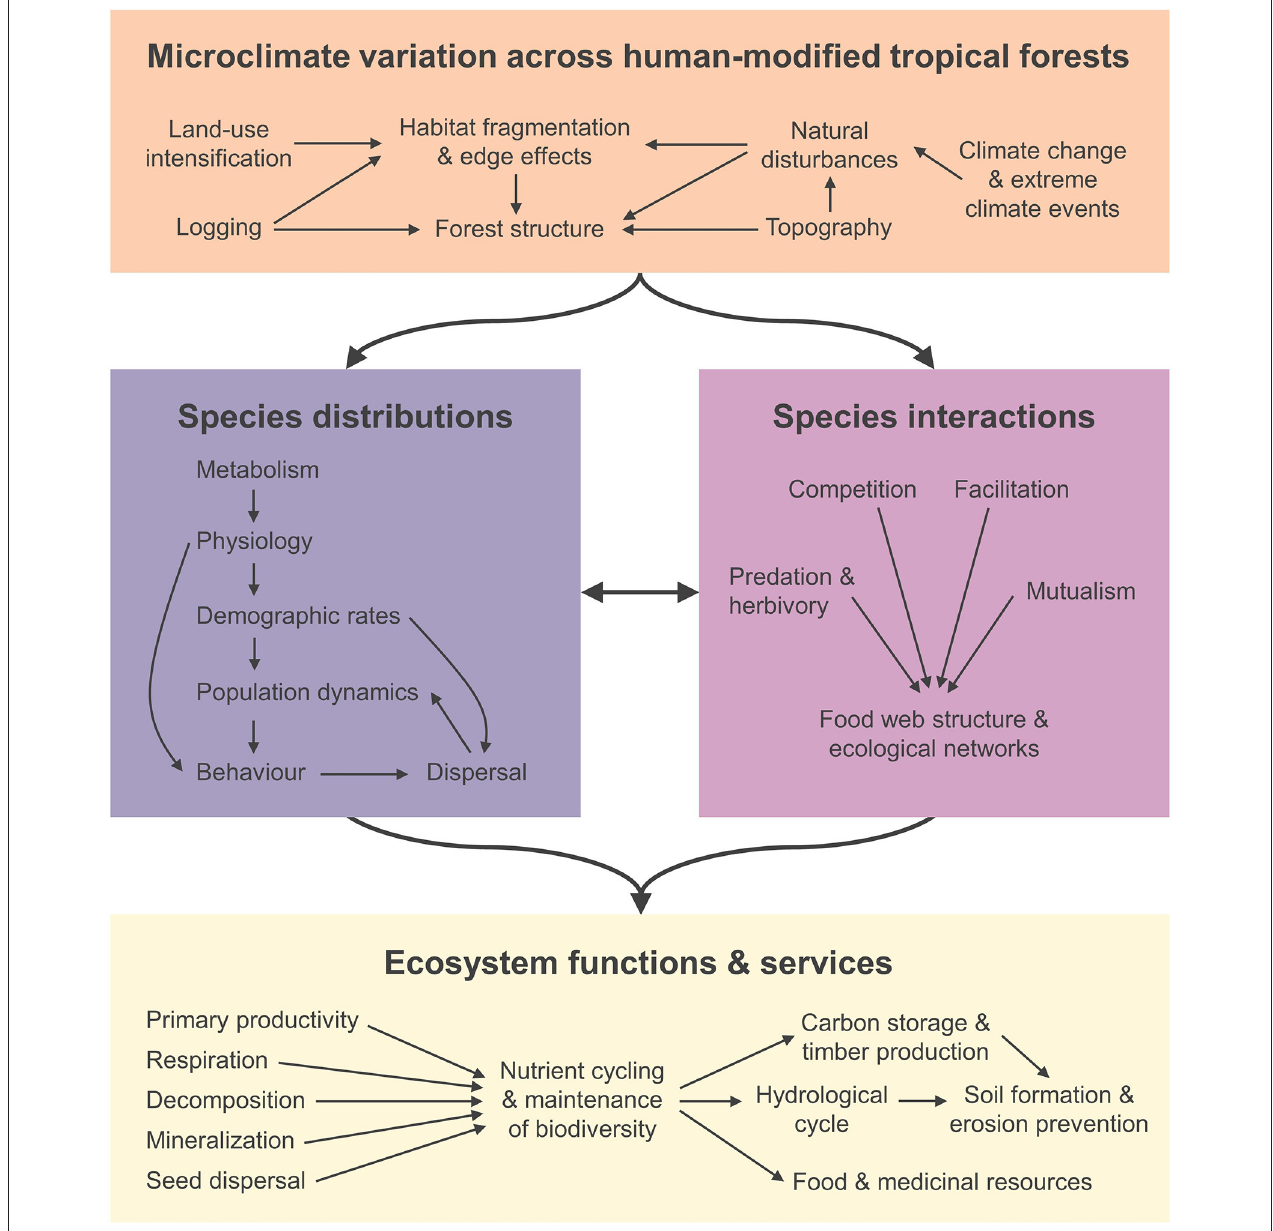
FIGURE 2 | Schematic diagram illustrating the key processes that drive variation in microclimate across human modified tropical forests, and how these in turn influence species distributions, their interactions and the ecosystem functions and services they